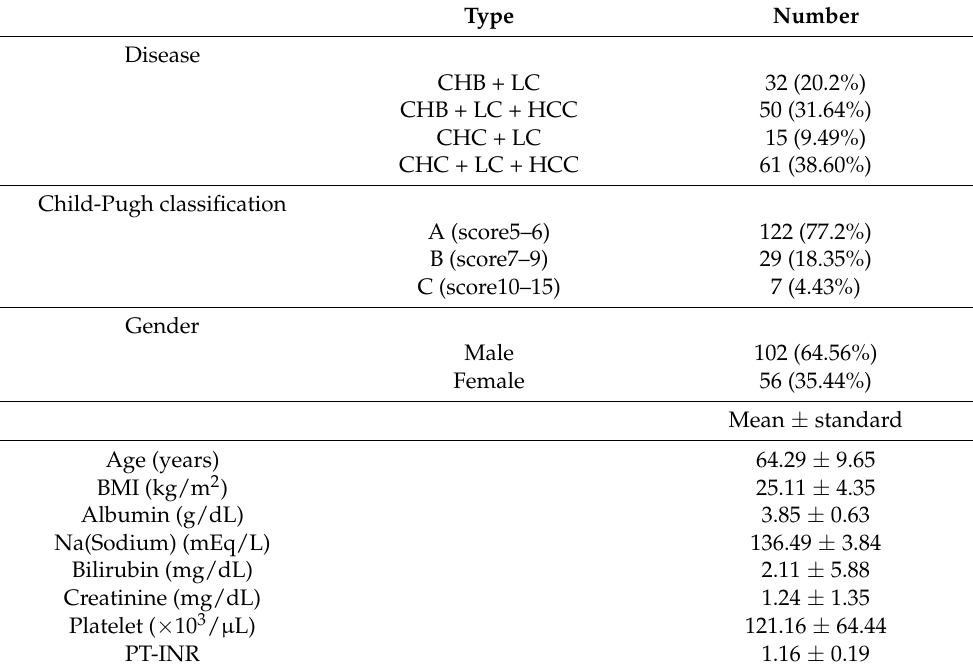
Table 1. Patient